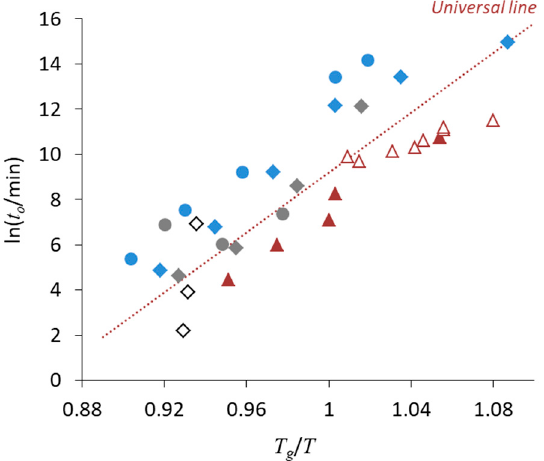
Figure 10. Onset crystallization time ( t o , min) of various ASDs as a function of T g / T . ( ◆ , ◆ , ◇ ) Nifedipine/PVP ASDs prepared by melt–quench [68,69] followed by milling [58], respectively. ( ● , ● ) Phenobarbital/PVP ASDs prepared by melt–quench [68,69]. ( ▲ , △ ) Sanofi–Aventis compound/HPMCP ASDs prepared by spray-drying stored under dried and humid conditions, respectively [70]. Definition of onset crystallization time, which is analogous to t 10 , is slightly different depending on the study, but its impact is ignorable in the analysis here. HPMCP, Hydroxypropyl methylcellulose phthalate.